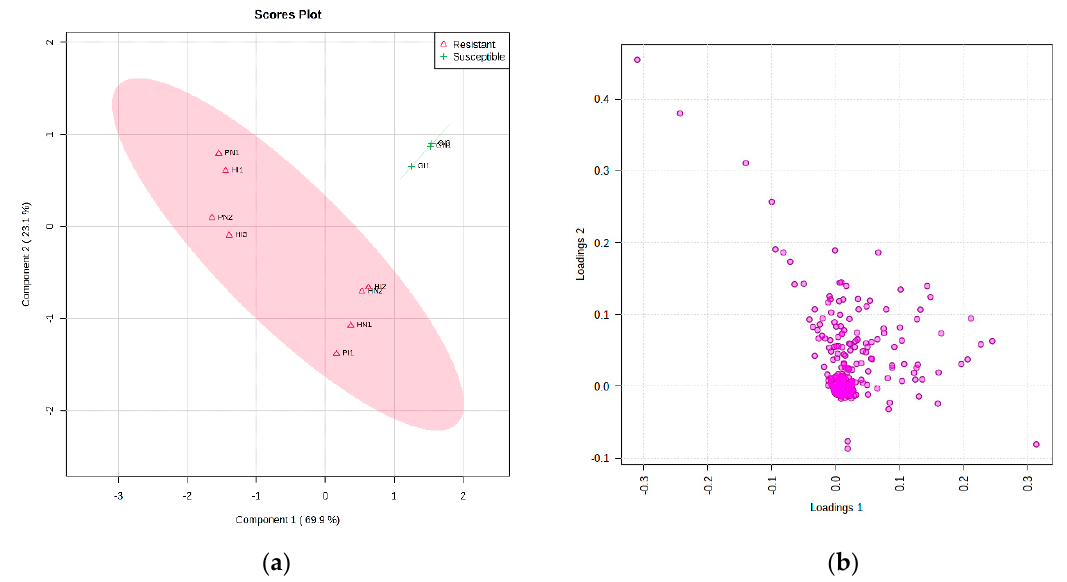
Figure 4. Scores ( a ) and loadings ( b ) of resistant and susceptible cultivars tomatoes with inoculation and non-inoculation. Non-inoculation of GM2 (GN), inoculation of GM2 (GI), Non-inoculation of Hawaii 7996 (HN), inoculation of Hawaii 7996 (HI), Non-inoculation of Permata (PN), inoculation of Permata (PI).